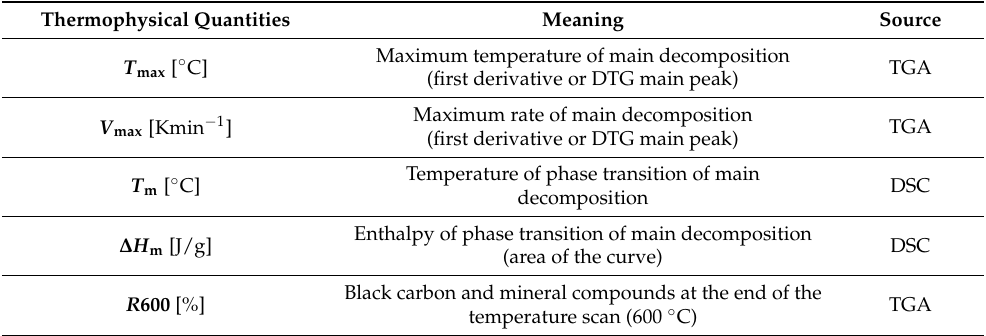
Table 2. Main thermophysical quantities from the thermal profiling of probiotic-based products.